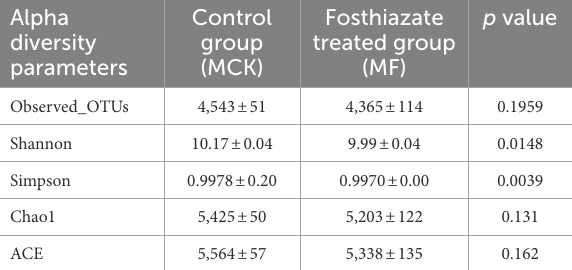
TABLE 3 The estimation of alpha diversity indices of bacterial communities of MCK and MF samples of Cucumis melo var. saccharinus